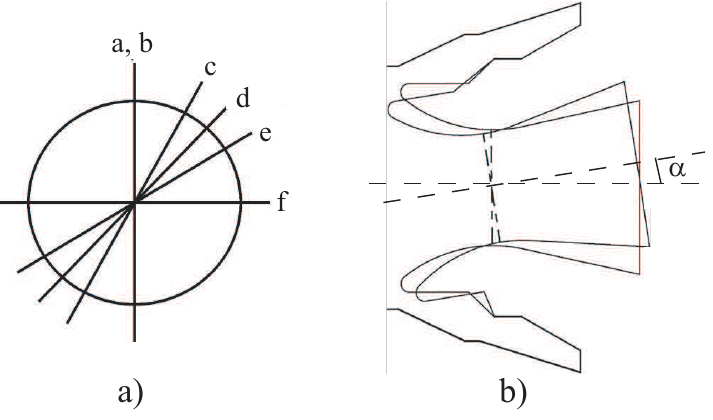
Figure 13. Locations of control sections ( a ) and nozzle rotation on angle α ( b